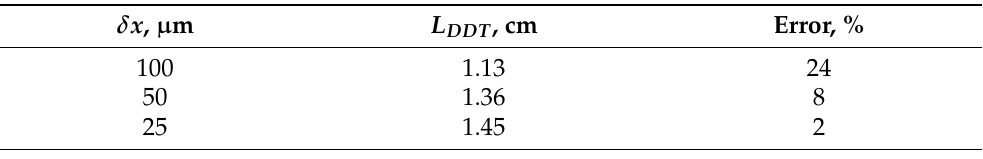
Table 1. Convergence test: numerical data on the cell size, L DDT , and error. Asymptotic value of L DDT and convergence order based on the estimation of L DDT is also given in the bottom row of the table.